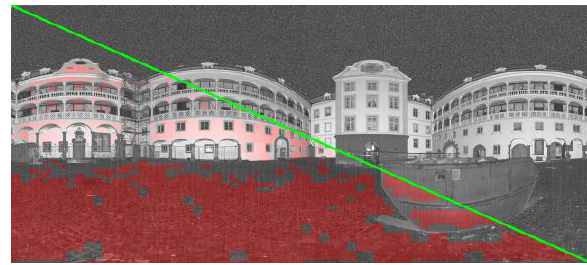
Figure 3. Generated intensity image (upper right) and detected planes tinted in red (lower left)